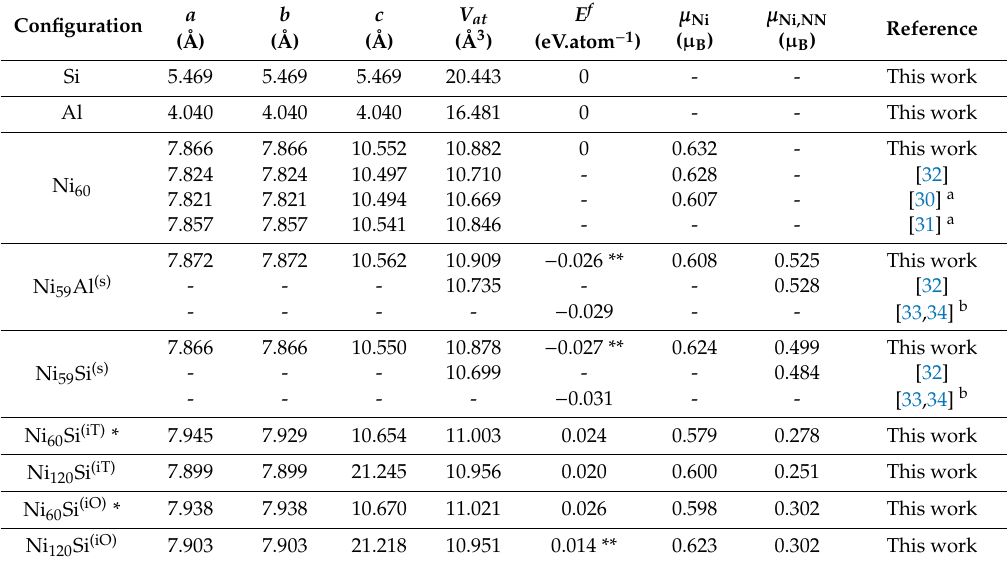
Table 1. Equilibrium properties of the bulk material of all three elements studied and fcc Ni containing impurities. Here, a , b and c stand for lattice parameters, E f is the energy of formation related to the standard element reference states: ferromagnetic fcc Ni, nonmagnetic fcc Al and nonmagnetic Si in the diamond structure (Equation (1)). µ Ni stands for the magnetic moment per atom obtained by averaging over all Ni atoms in the structure and µ Ni,NN denotes the magnetic moment of Ni atom that is the nearest neighbor of the impurity. Superscripts (s) and (iT) or (iO) mark the substitutional or interstitial impurity position. The fcc supercell lattice parameters obtained from literature were derived from the lattice parameters of fcc Ni unit cell a = 3.498 Å [30] and a = 3.5138 Å